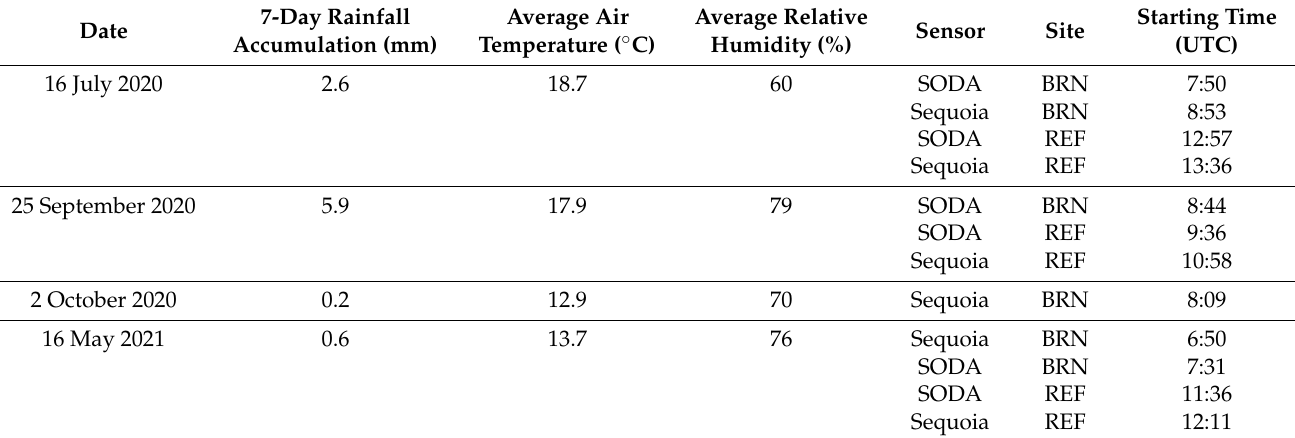
Table 1. Summary of imagery acquisition schedule and meteorological conditions during the UAS flights, according to the Estonian Meteorological and Hydrological Institute